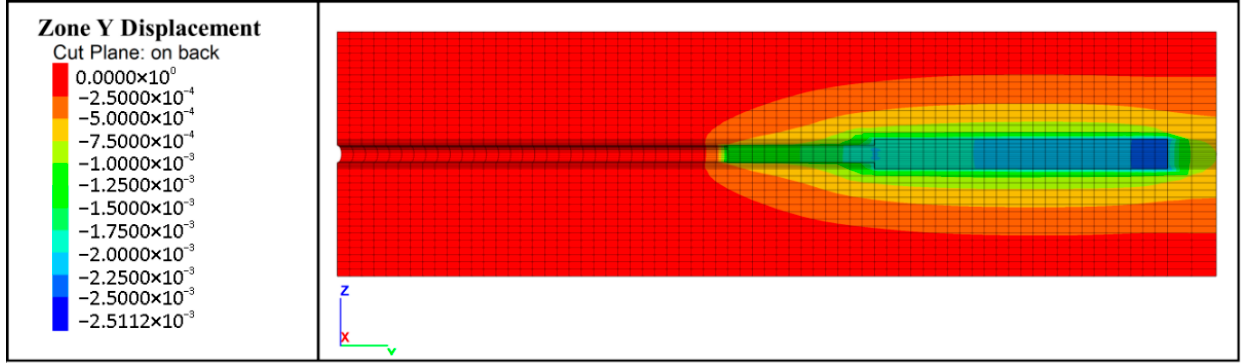
Figure 10. Model displacement contour diagram when the anchor cable tension F = 500 kN.